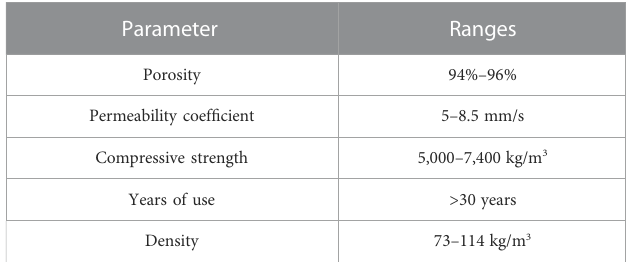
TABLE 1 The parameter of